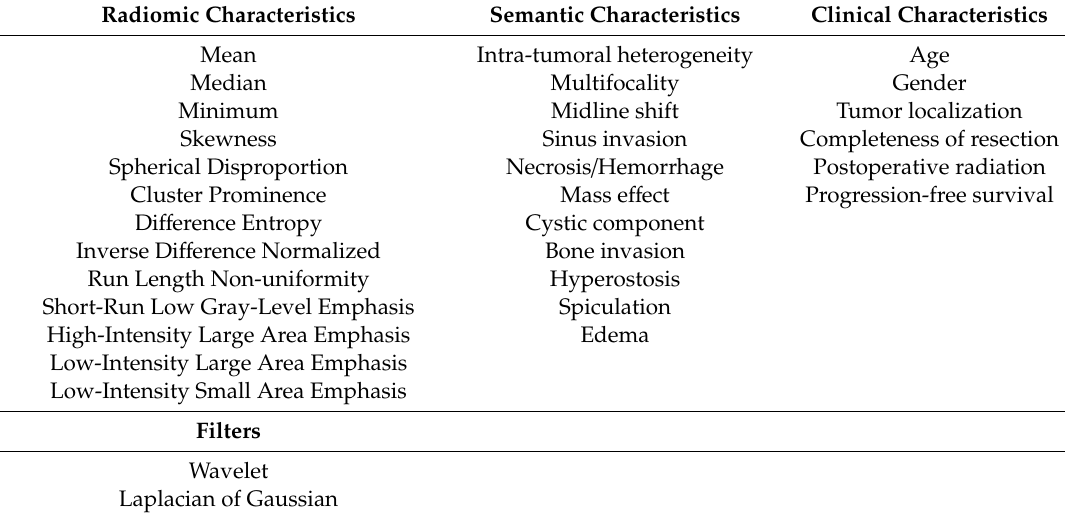
Figure 2. Progression-free survival after surgery of atypical meningiomas with vs. without “cystic component”. Table 4. Radiomic, semantic and clinical data used in the analysis. More detailed explanation of radiomic and semantic features is provided in Supplementary Materials Table S1.